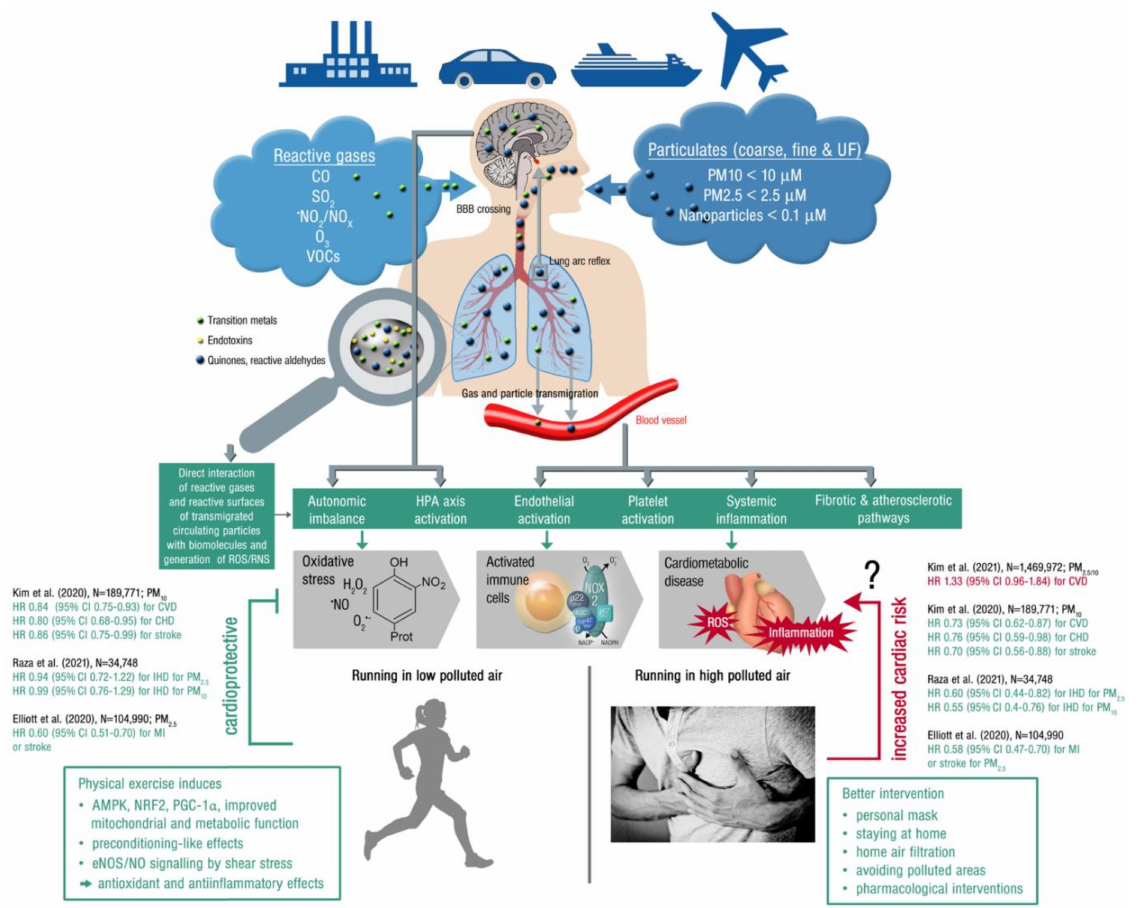
Figure 4. Upper part: Summary of pathophysiological mechanisms by which air pollutants cause increased oxidative stress and inflammation, thereby contributing to cardiometabolic disease. Uptake and cardiorespiratory health effects triggered by air pollution constituents. Middle part: Key events that contribute to increased cardiometabolic risk by air pollution constituents. Ambient PM is often loaded with environmental toxins stemming from particle “aging” by UV induced photoreactions or modifications upon interaction with reactive gases in the atmosphere [175]. In addition, loading of the particles with environmental endotoxins and transition metals enhances their direct biochemical reactivity. Summarized from [32] (upper part; Copyright © 2021, Oxford University Press) and [176] (middle part; © 2021 International Union of Biochemistry and Molecular Biology) with permission. BBB, blood–brain barrier; UF, ultrafine; ROS/RNS,